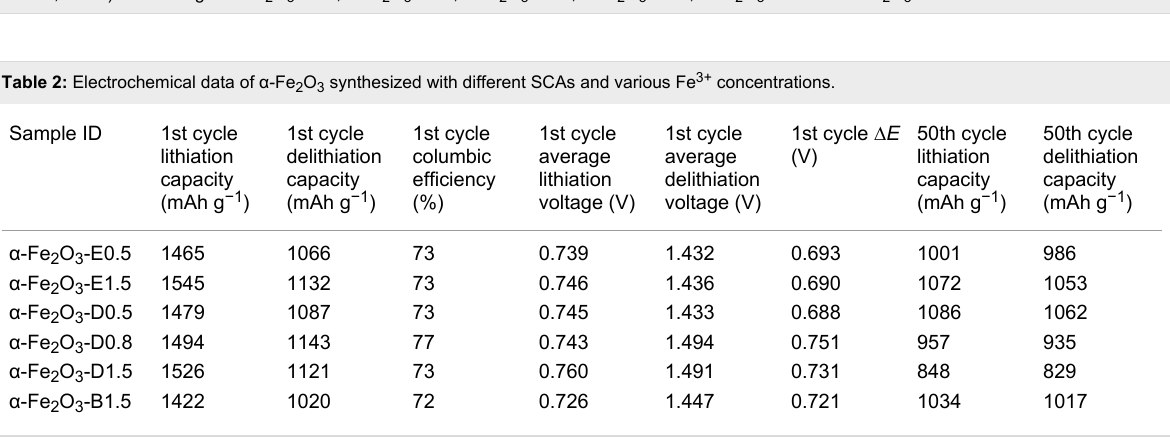
Figure 8: a) Galvanostatic delithiation/lithiation profiles (1st, 2nd and 5th cycle) for α -Fe 2 O 3 -E1.5, b) 1st and 2nd cycle comparison, c) cycling perfor- mance, and d) rate testing of α -Fe 2 O 3 -E0.5, α -Fe 2 O 3 -E1.5, α -Fe 2 O 3 -D0.5, α -Fe 2 O 3 -D0.8, α -Fe 2 O 3 -D1.5 and α -Fe 2 O 3 -B1.5.